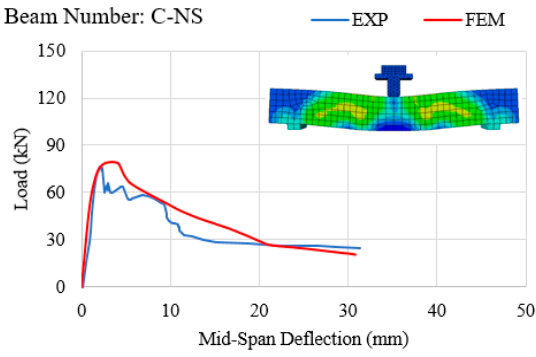
Figure 13. Load vs. mid-span deflection for BI-600-GFRP.